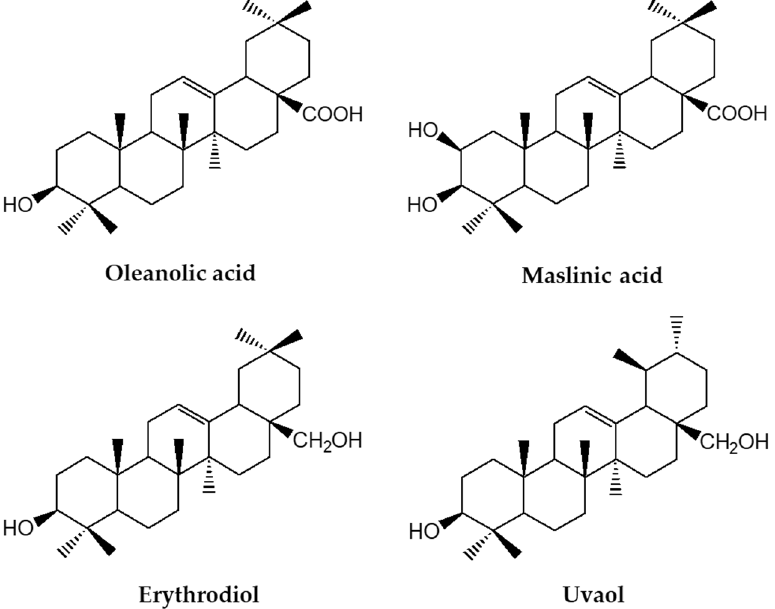
Figure 1. Chemical structures of most important triterpenic acids and alcohols in olive oil.